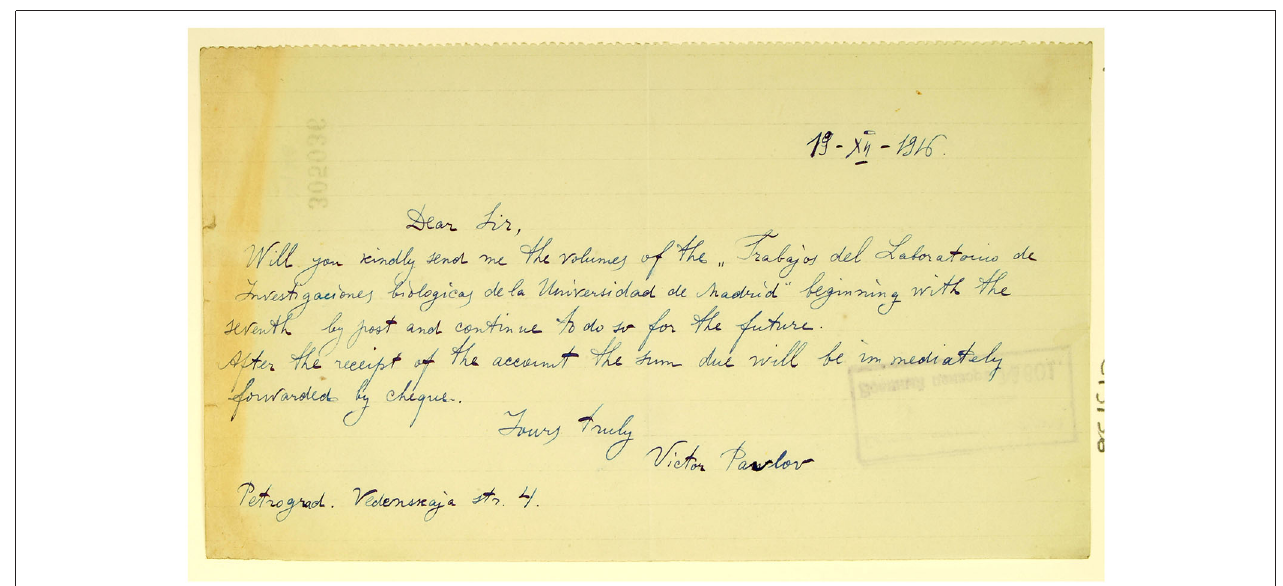
FIGURE 5 | Letter from the “Legado Cajal” from Victor Pavlov to Cajal in 1916 (Cajal Institute, CSIC, Madrid)